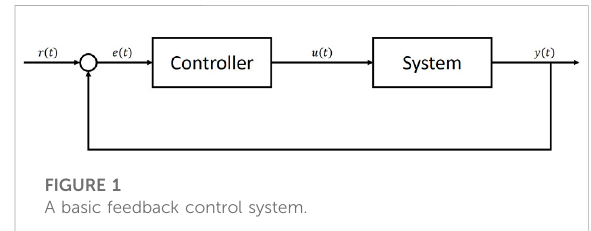
A basic feedback control